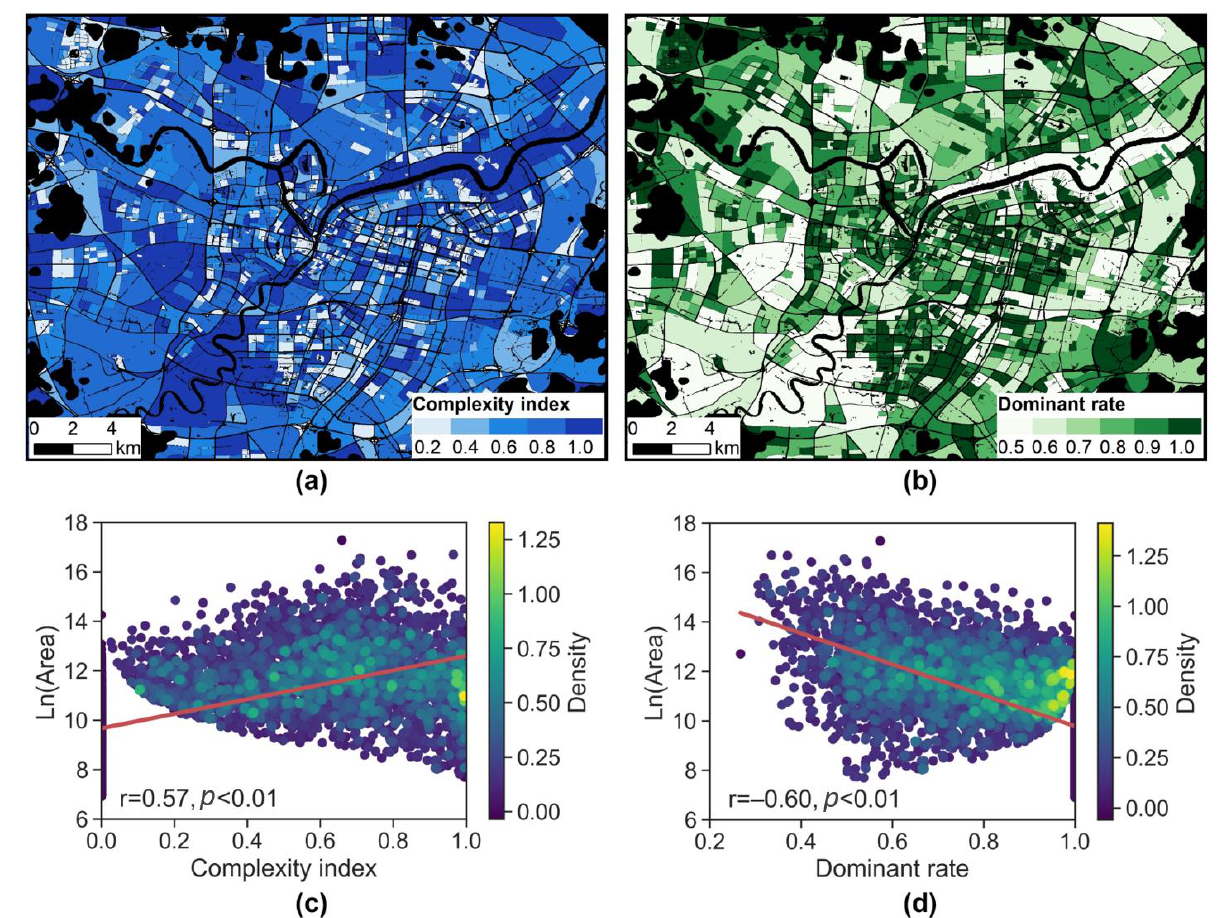
Figure 5. Land use mix of Level I categories in Ningbo. ( a ) Maps of complexity index in the city center. ( b ) Maps of dominant rate in the city center. ( c ) The relationship between complexity index and area of parcels. ( d ) The relationship between dominant rate and area of parcels. r in ( c , d ) represents the Pearson correlation